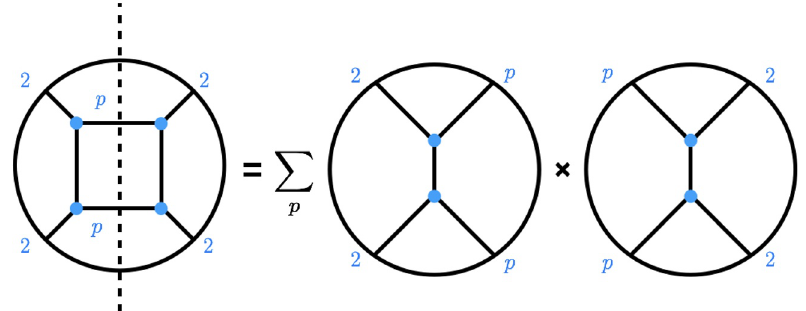
Figure 1 . Higher KK-modes run inside the loop when considering loop corrections to the stress tensor four point